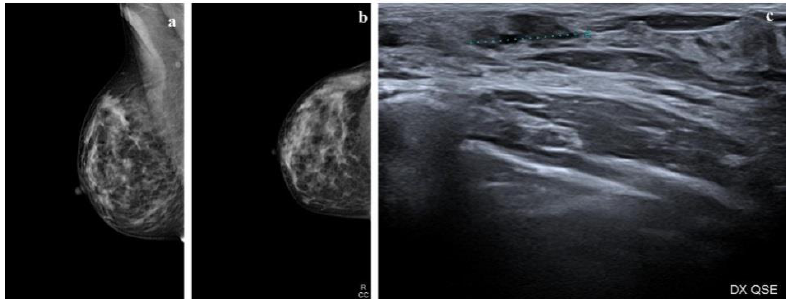
Figure 1. Radiologic features of a low-grade ductal carcinoma in situ (DCIS) lesion. ( a , b ) Mammograms show a heterogeneously dense right breast. In the upper outer quadrant (UOQ) there is a small oval opacity with obscured margins; ( c ) ultrasound shows an irregular mass with indistinct margins, hypoechoic echo pattern without posterior features.